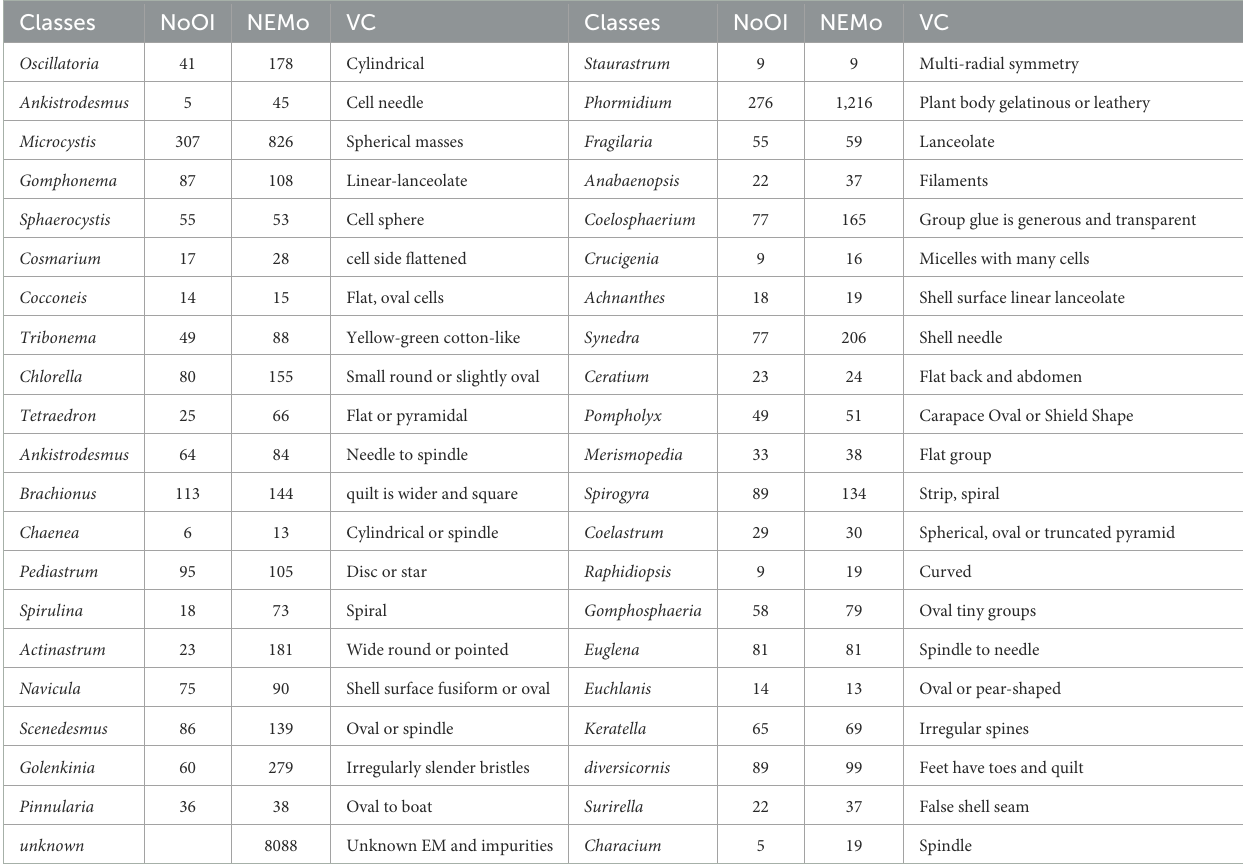
TABLE 1 Basic information of 42 EM classes in